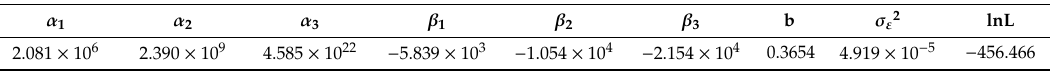
Table 8. The estimates of unknown parameters for O-type rubber sealing rings.